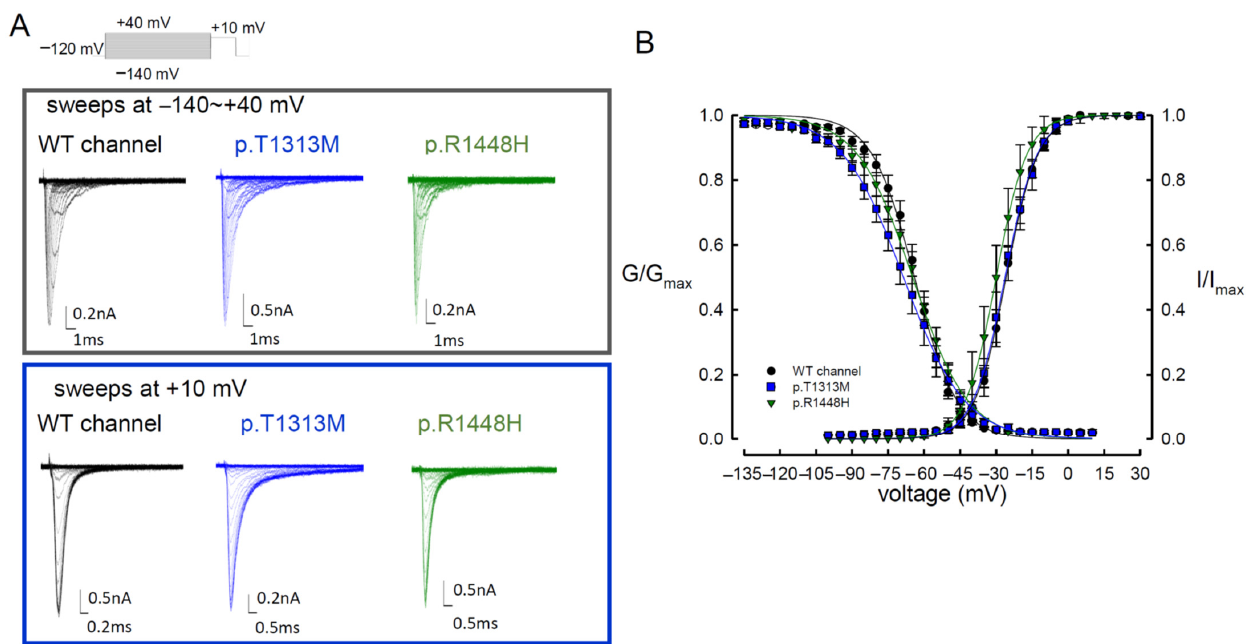
Figure 1. Activation and Inactivation Curves of WT, p.T1313M, and p.R1448H Mutant Na v 1.4 Channels in the Presence of 100 μ M Na v β 4 Peptide. ( A ) Representative current traces for the WT, p.T1313M, and p.R1448H mutant Na v 1.4 channels (activation in the upper panel, inactivation in the lower panel) in the presence of 100- μ M Na v β 4 peptide. ( B ) The steady states of the activation and fast inactivation curves of the WT, p.T1313M, and p.R1448H mutant Na v 1.4 channels were fitted with Boltzmann function: 1/[1 + exp((V h − V)/k)], where V is the membrane voltage, V h and k are − 24.7 ± 1.5 mV and 6.85 ± 0.25 for the activation curve and − 61.9 ± 0.9 mV and − 8.9 ± 0.3 for the fast inactivation curve in the WT Na v 1.4 channel, − 26.29 ± 1.8 mV and 6.76 ± 0.57 for the activation curve and − 68.6 ± 0.34 mV and − 12.82 ± 0.28 for the fast inactivation curve for the p.T1313M mutant channel, and − 30.0 ± 1.5 mV and 6.4 ± 0.45 for the activation curve and − 64.78 ± 0.45 mV and − 11.6 ± 0.38 for the fast inactivation curve for the p.R1448H mutant channel ( n = 5). Table 1. Parameter of voltage-dependent activation and steady state fast inactivation of WT and mutant channels. WT Channel p.T1313M p.R1448H Activation Inactivation Activation Inactivation Activation Inactivation − 24.7 ± 1.5 6.9 ± 0.3 − 61.9 ± 0.9 − 8.9 ± 0.3 − 68.6 ± 0.3 − 12.8 ± 0.2 − 30.0 ± 1.5 6.4 ± 0.5 − 64.78 ± 0.5 − 11.6 ± 0.4